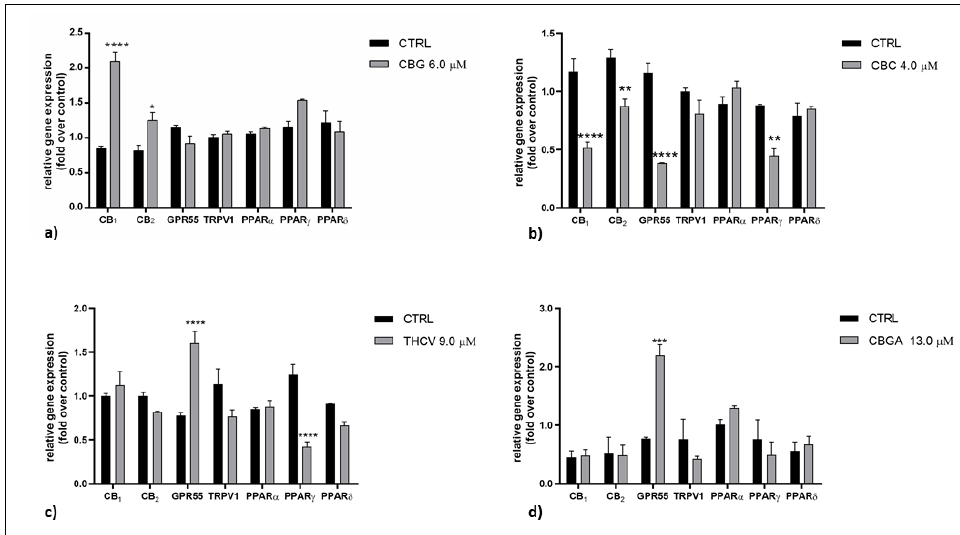
Figure 2. Gene expression of eCB-binding receptors (CB 1 , CB 2 , GPR55, TRPV1 and PPARα/γ/δ)